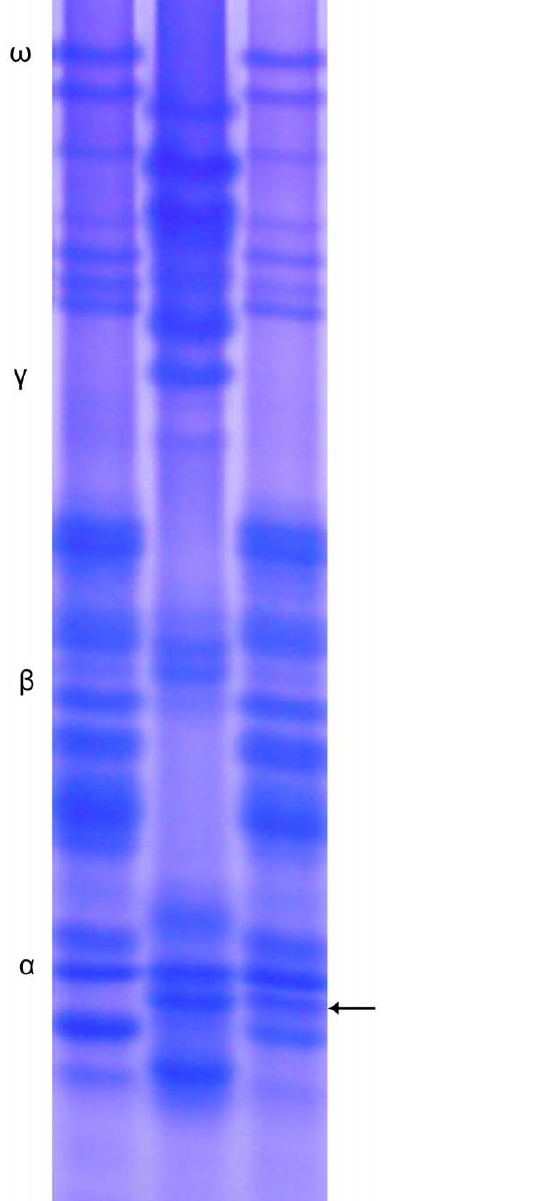
Figure 5. A-PAGE analysis of the disomic addition line and its parents, wheat cv. 7182 and Psathyrostachyshuashanica . 1 7182, 2 Psathyrostachys huashanica , 3 59-11. The arrow shows specific bands from Psathyrostachys huashanica that appeared as a -gliadin in